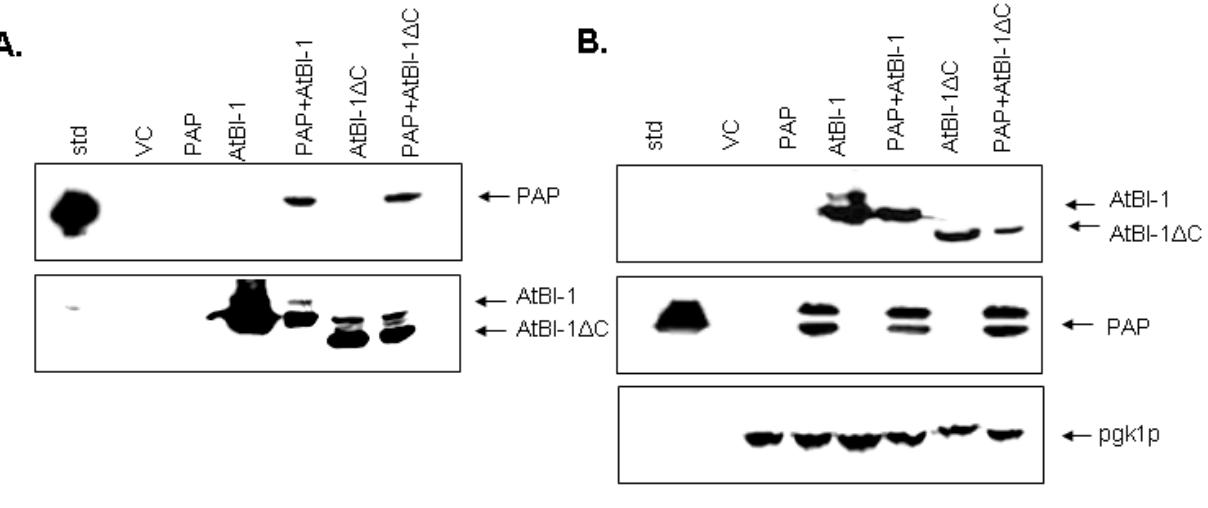
FIGURE 8 : Co-immunoprecipitation assay. (A) Co-immunoprecipitation of PAP with either AtBI-1 or AtBI-1ΔC. Total proteins isolated from yeast cells induced to express PAP, AtBI-1, AtBI-1ΔC and vector control (VC) for 6 hours were incubated with V5-antibody and immunoprecip- itated with protein A-Sepharose beads. Immunoprecipitated proteins were separated on 15 %SDS-PAGE, transferred to nitrocellulose and probed with affinity purified PAP antibody or with V5-antibody. (B) The total lysate from cells expressing PAP, AtBI-1 and AtBI-1ΔC subjected to SDS PAGE/immunoblot analysis using V5 and PAP-antibody to show the level of expression of both